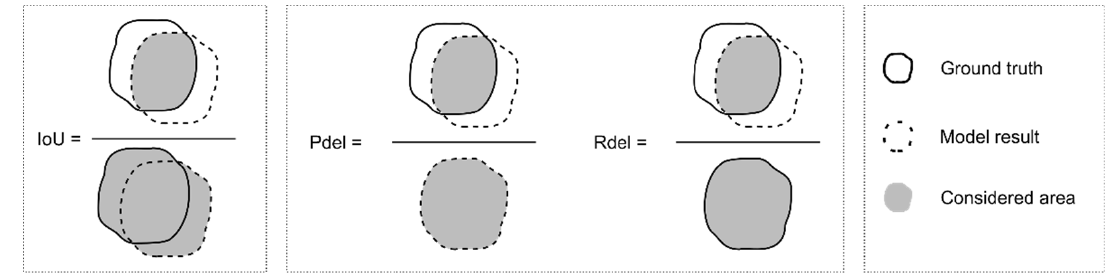
Figure 7. Schematic illustration of delineation metrics.